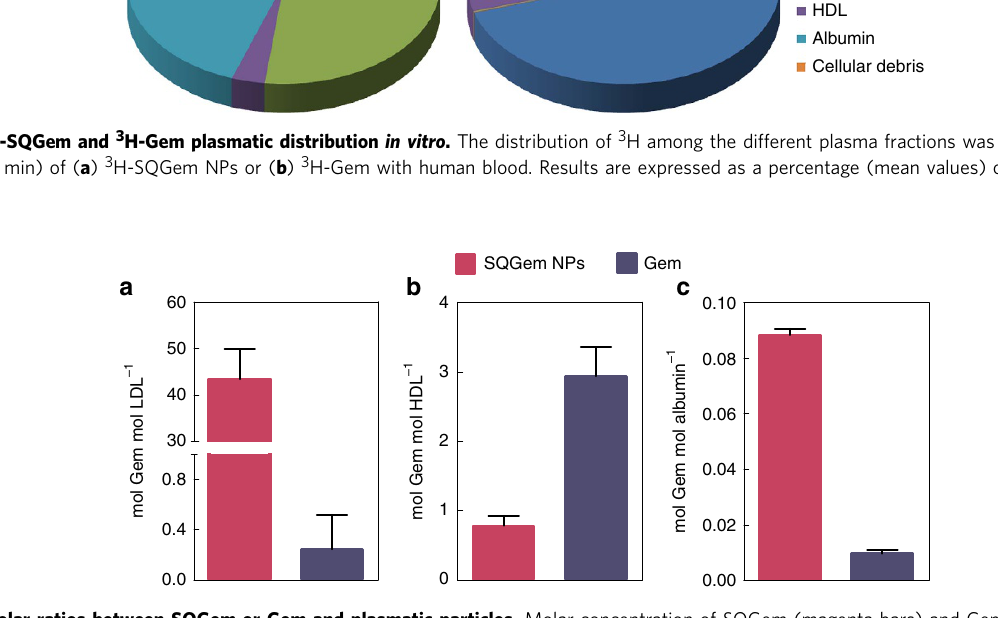
Figure 2 | Molar ratios between SQGem or Gem and plasmatic particles. Molar concentration of SQGem (magenta bars) and Gem (blue bars) per mole of ( a ) LDL, ( b ) HDL and ( c ) albumin after incubation with total human blood (5min). Bars represent mean ± s.e.m.